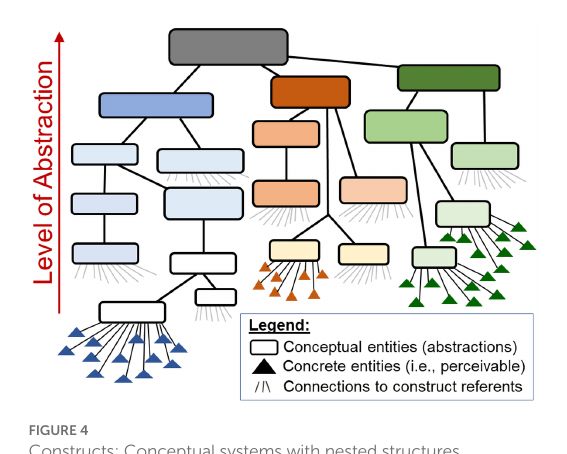
FIGURE 4 Constructs: Conceptual systems with nested